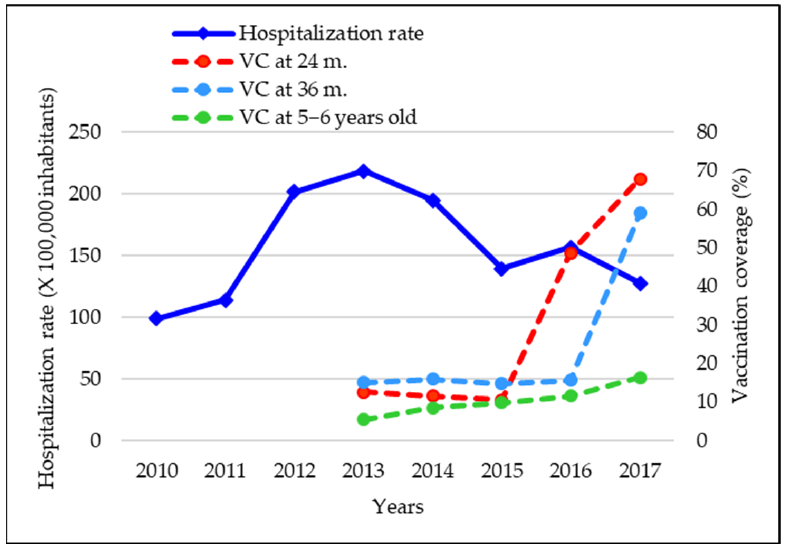
Figure 2. Varicella ED accesses/hospitalizations per 100,000 inhabitants and vaccination coverage (VC) in Liguria at 24, 36 months and 5–6 years of age.